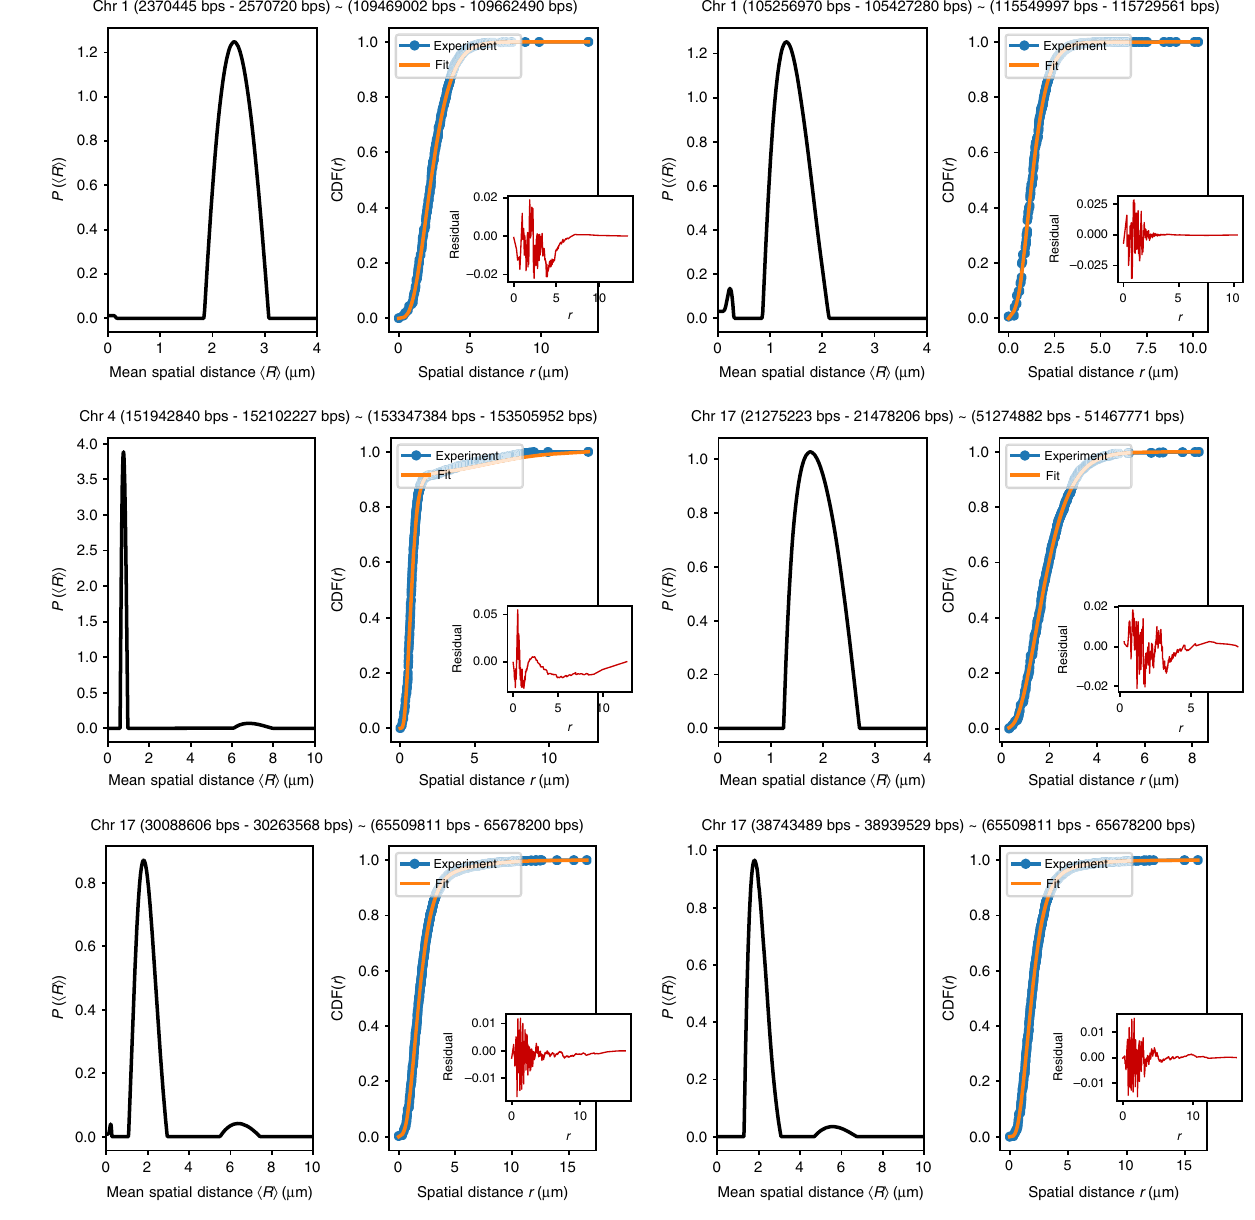
Fig. 5 Exampled fi ts of CDF( r ) using Supplementary Eq. (9) to the experimental data 19 . The six exampled pairs of loci are indicated above each sub fi gure. Orange lines, showing the fi ts using our theory, are indistinguishable from the experiment (the differences between fi tted and experimental curve are shown in the insets). The distribution P ( 〈 R 〉 ) given in the integral equation (Supplementary Eq. (9)) is solved using nonnegative Tikhonov Regularization (Supplementary Note 7). As shown here, P ( 〈 R 〉 ) have multi-peaks and are widespread, which is a manifestation of heterogeneity. We set g = 1 and δ =